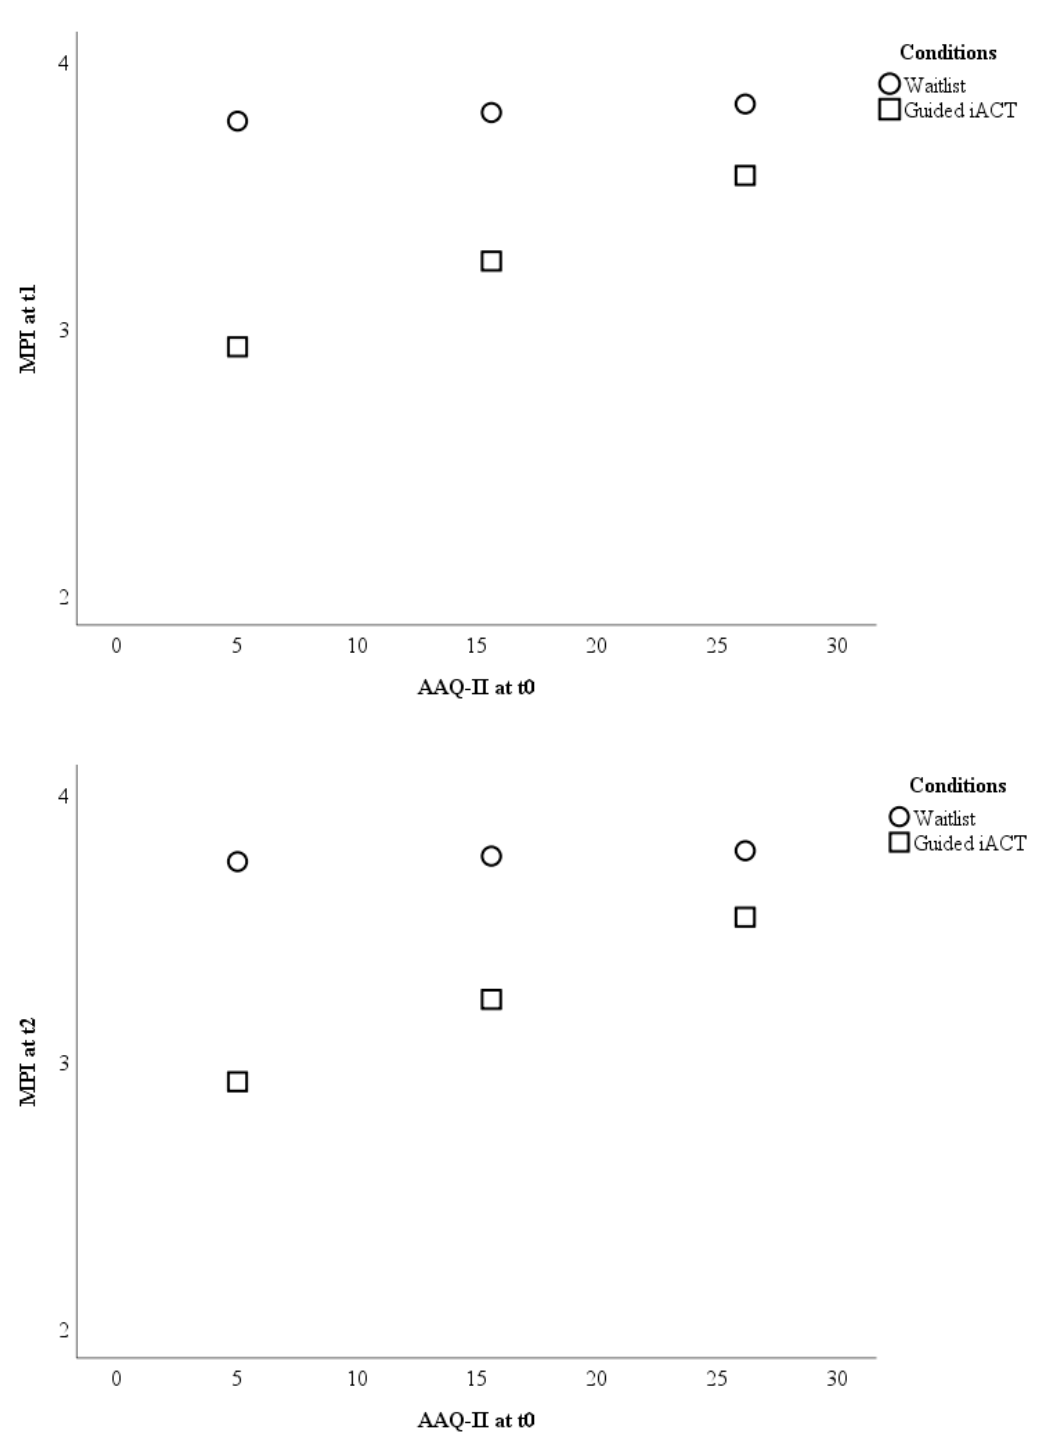
Figure 1. Visualizations of the results testing baseline psychological inflexibility as a moderator of the treatment outcome pain interference between waitlist and guided Internet-based ACT. The outcome ( Y -axis) is displayed for three different levels (sample mean ± 1 standard deviation) of psychological inflexibility ( X -axis). Note: AAQ-II = Acceptance and Action Questionnaire; iACT = Internet-based Acceptance and Commitment Therapy; MPI = Pain interference scale of the Multidimensional Pain Inventory; t0 = baseline; t1 = 9-weeks after randomization; t2 = 6-months after randomization.